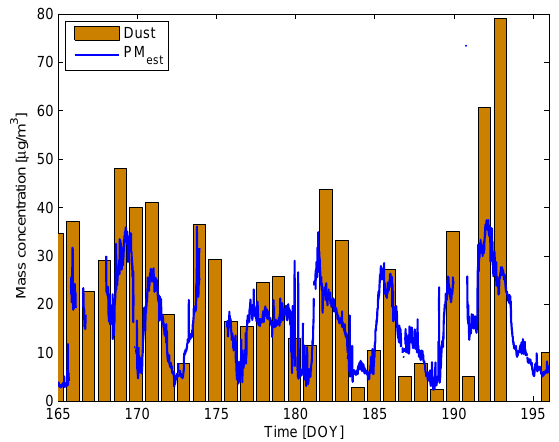
Figure 4. The mineral dust mass concentration (bars) in the total suspended particulate matter and the particulate matter concentra- tion (PM est , blue line) estimated from the integrated particle vol- ume size distribution for diameters in the range 0.5–10µm assum- ing spherical particles and a particle density of 2.6gcm − 3 . The gap in the mineral dust concentration around DOY = 194–195 is due to lack of data for those 2